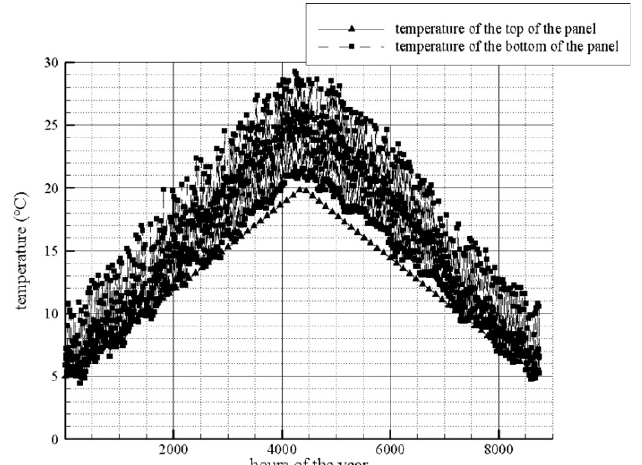
Figure 10. temperature of the top and the bottom of panel during the year According to the statement of the dam authorities, water temperature varies from 5ºC in the coldest day of the year to 20ºC in the hottest day of the year. In this research, it is assumed that the water temperature varies linearly during the year. Temperature distribution in solar cell is obtained by assuming: one dimensional heat transfer in cell, constant temperature boundary condition under the cell, and constant heat flux boundary condition above the cell. The steady state energy equation is solved in one-hour intervals which boundary conditions can